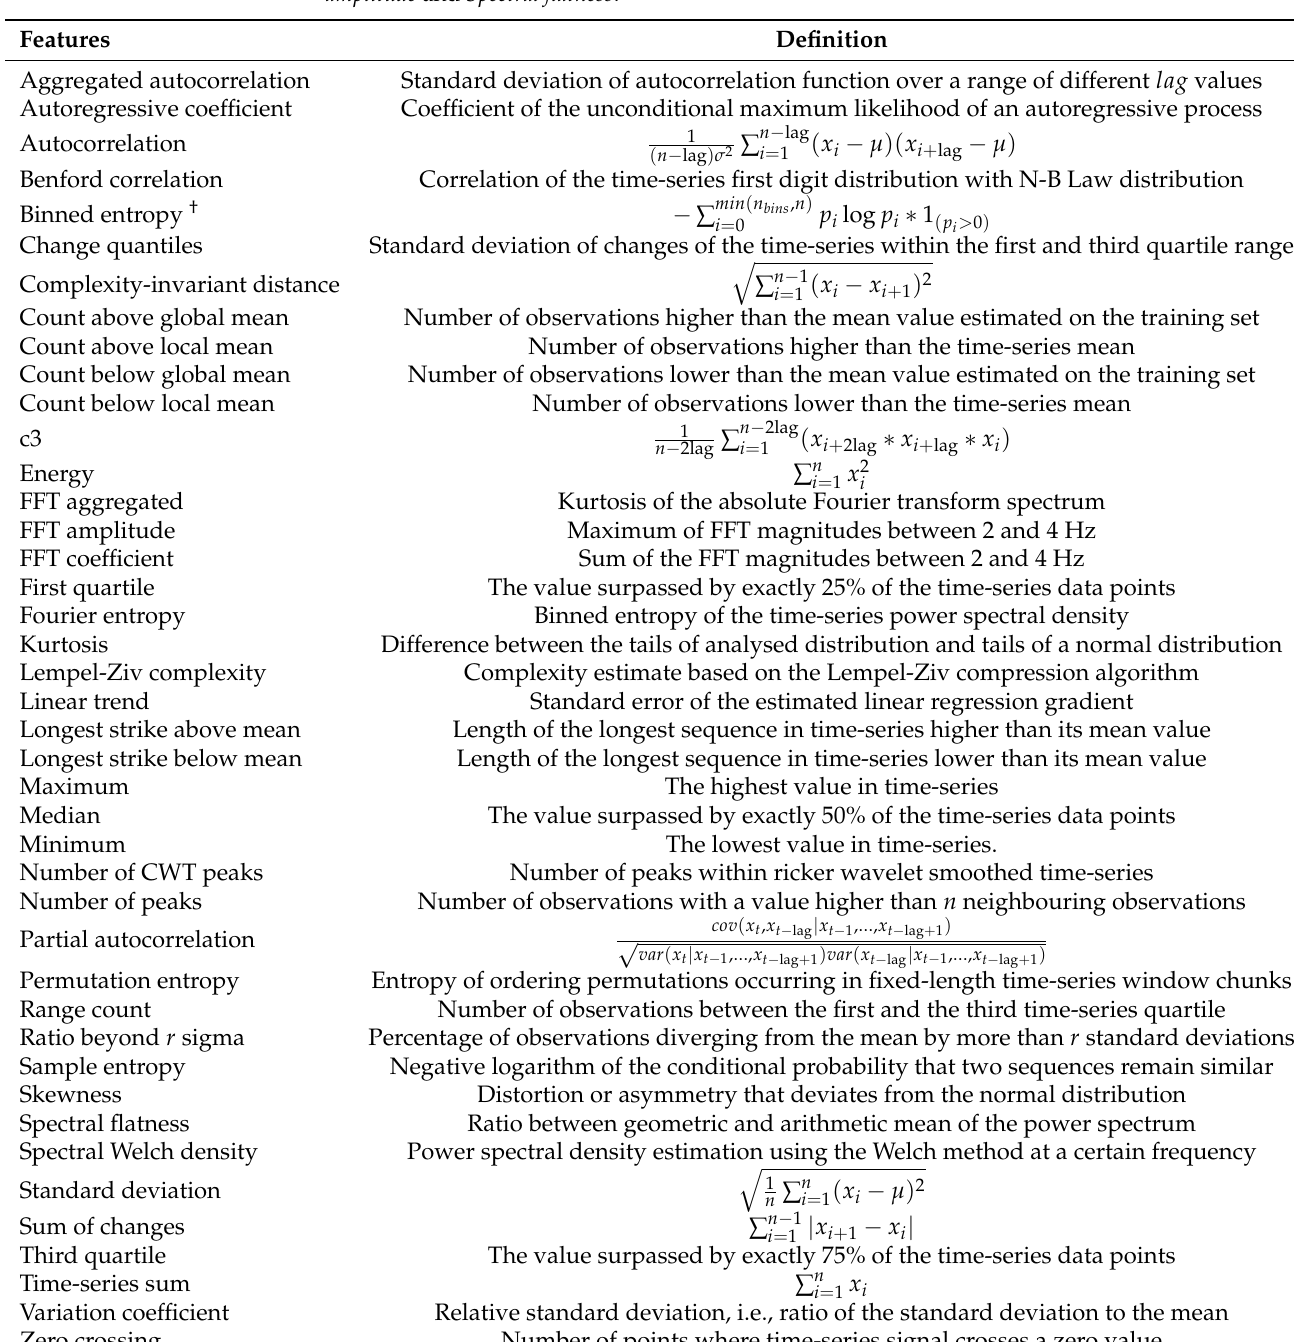
Table A1. Brief description of generic and knowledge-specific time-series features. All the features used within the analysis are derived using the tsfresh Python package [23] with the exception of FFT amplitude and Spectral flatness